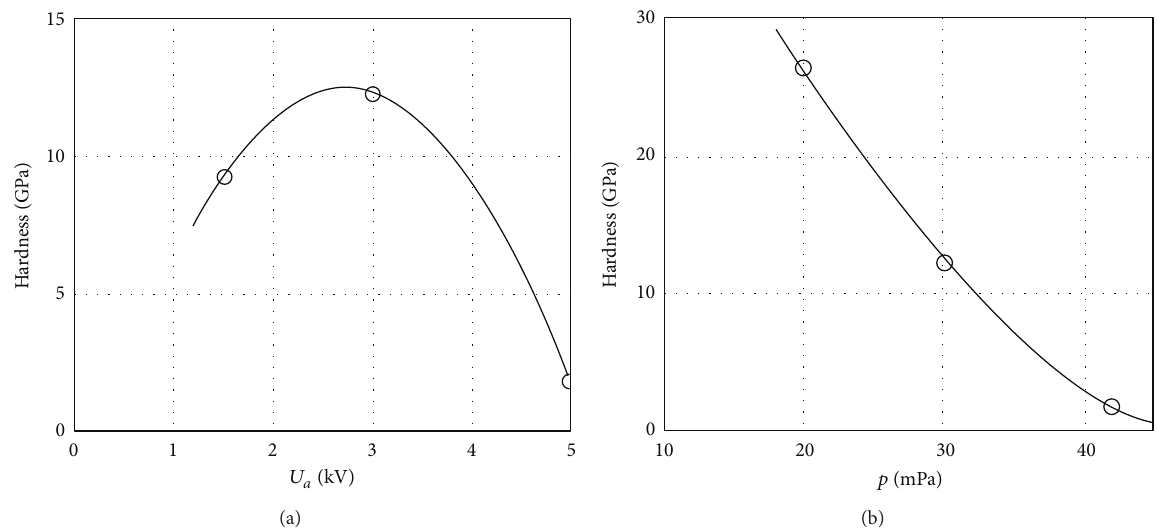
Figure 4: Dependence of the film hardness on the accelerating voltage at a fixed gas pressure p = 30mPa (a) and the gas pressure at a fixed acceleration voltage 𝑈 𝑎 = 5 kV (b).